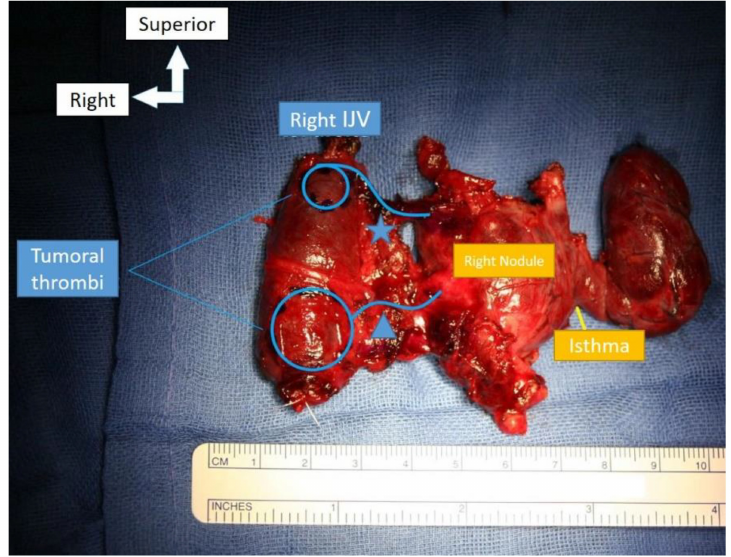
Figure 3. Total thyroidectomy with partial resection of the internal jugular vein (IJV) after ligature. Bifocal thrombotic invasion of the IJV by the middle (*) and inferior ( ∆ ) thyroid veins.